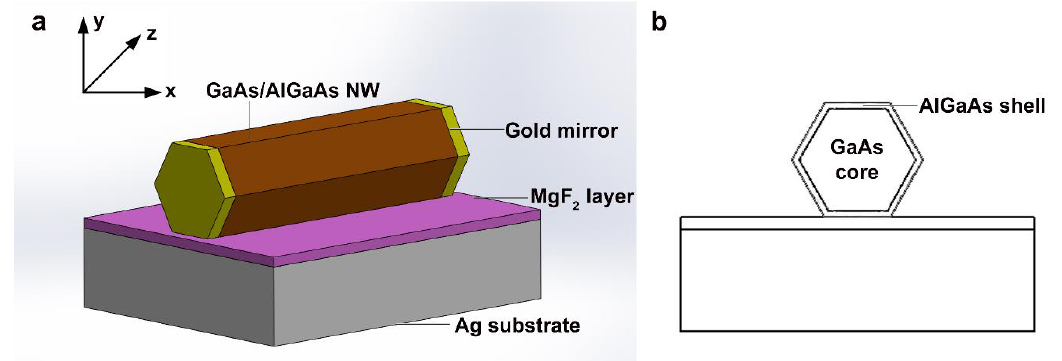
Figure 1. Schematic diagrams of the surface plasmon polariton laser with gold mirrors (SPPG). ( a ) 3D model and ( b ) sectional view.